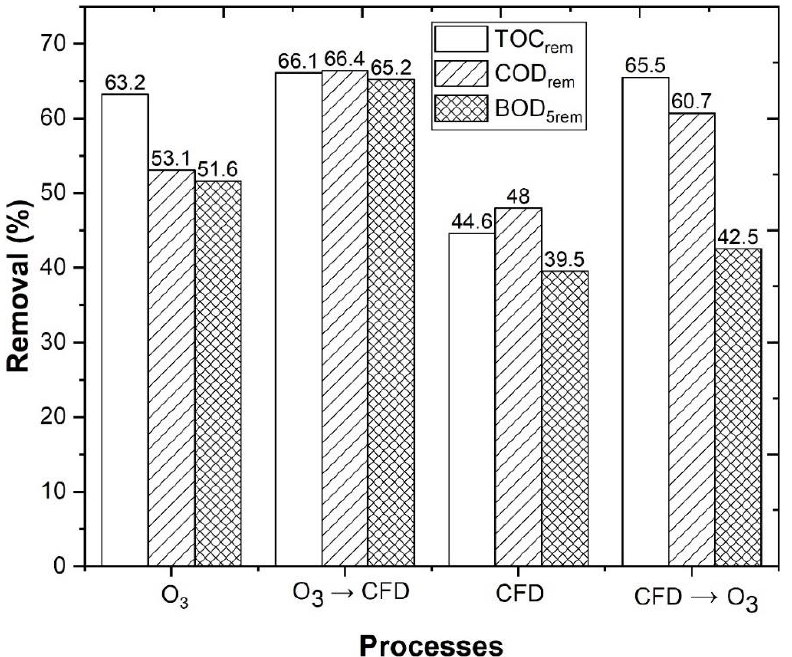
Figure 9. TOC, COD and BOD 5 removal. CFD operational conditions, as follows: 0.48 g/L potas- sium caseinate, 0.52 g/L bentonite, pH 4.0, temperature 298 K, rapid mix 150 rpm/3 min, slow mix 20 rpm/20 min, sedimentation time 12 h. O 3 /Fe 2+ /UV-C experimental conditions, as follows: pH = 4.0, [Fe 2+ ] = 1.0 mM, ozone flow rate 5 mg/min, air flow 1.0 L/min, agitation 350 rpm, time 600 min, radiation UV-C mercury lamp (254 nm).